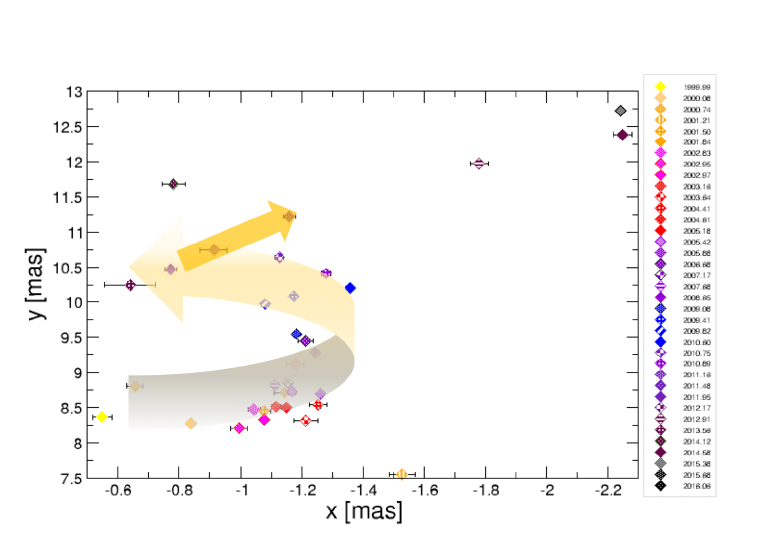
Figure 6. A zoom into the cyan box from Figure 3. An arrow is superimposed which indicates the general trend of motion (from grey to yellow). Again, there is some hint for the most recent data points to move “backwards” (indicated by the small orange arrow).